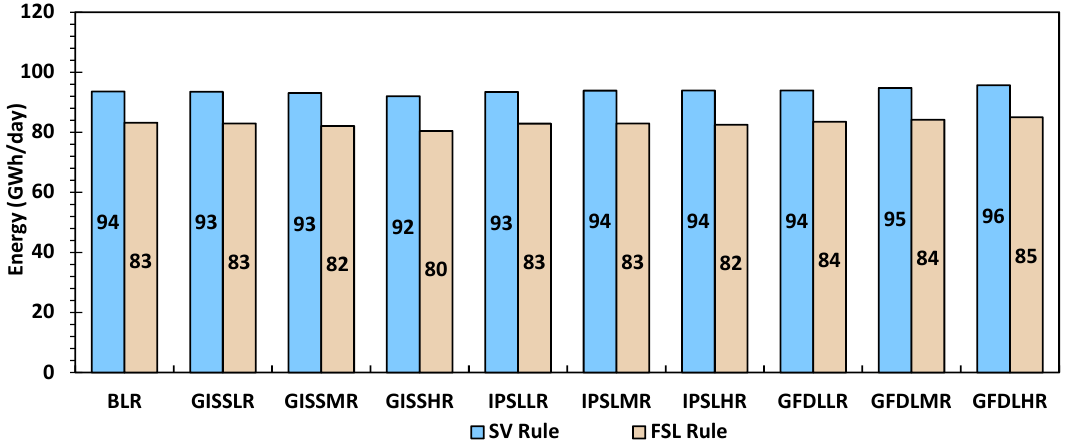
Figure 7. Average daily energy generation using the seasonal variation rule curve (SV rule) and full supply rule (FSL rule) curve for the baseline climate (BLR) scenario and for each emissions scenario (L—low, M—medium and H—high emissions) of the GISS, GFDL and IPSL models due to operation of reservoirs (R—reservoir operations).